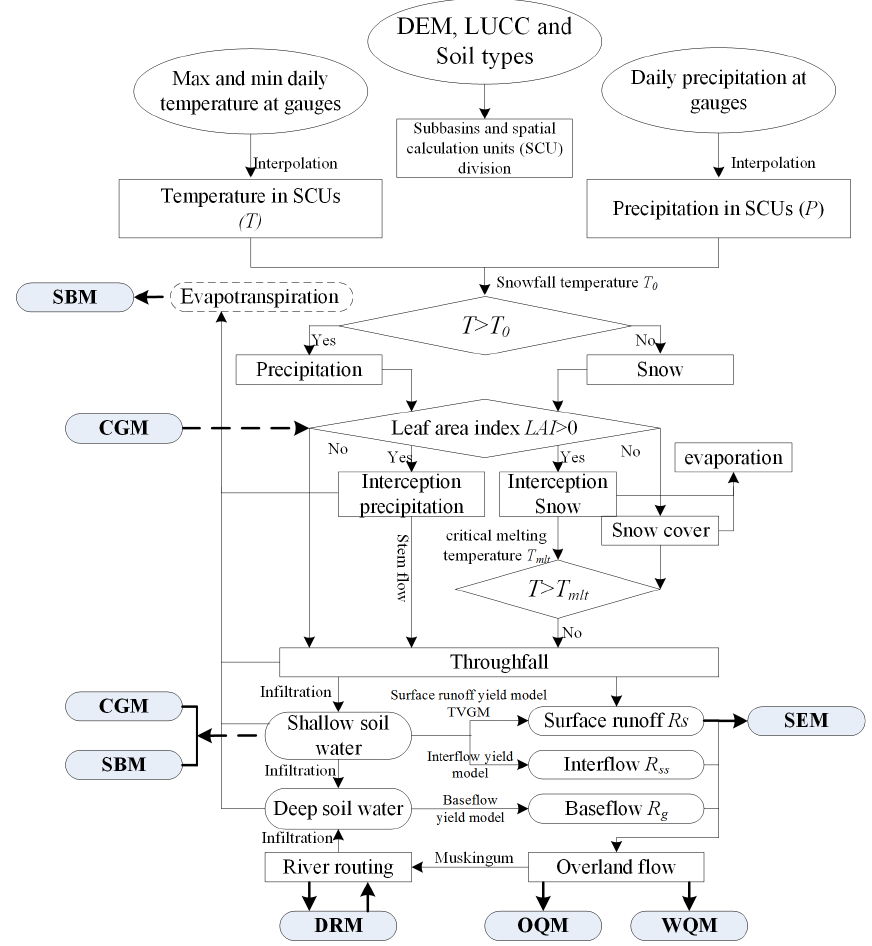
Figure 2. The flowchart of HCM and the interactions with other